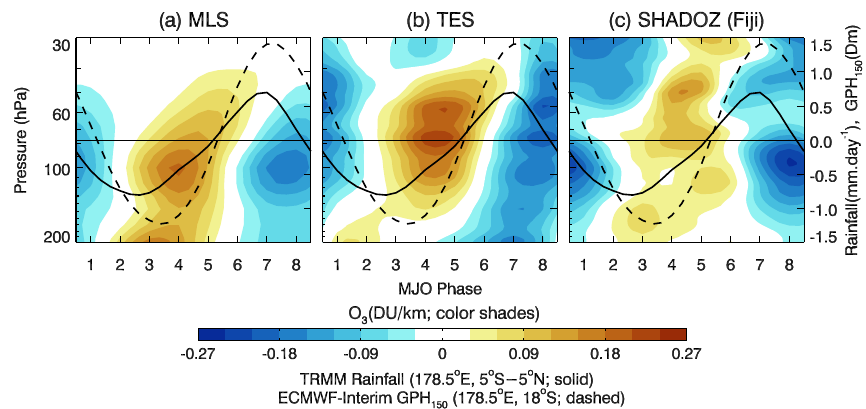
Fig. 10. Vertical structures of the O 3 anomalies over Fiji (178.40 ◦ E, 18.13 ◦ S) from (a) MLS, (b) TES and (c) SHADOZ as a function of MJO phase for the composite MJO life cycle. The MLS and TES O 3 anomalies are obtained by averaging the swath footprints that fall into the 10 ◦ -longitude × 8 ◦ -latitude box centered at Fiji. Solid lines denote MJO-related rainfall anomalies from TRMM averaged between 5 ◦ S and 5 ◦ N at 178.5 ◦ E. Dashed lines represent GPH 150 anomalies at (178.5 ◦ E, 18 ◦ S) from ERA-Interim.